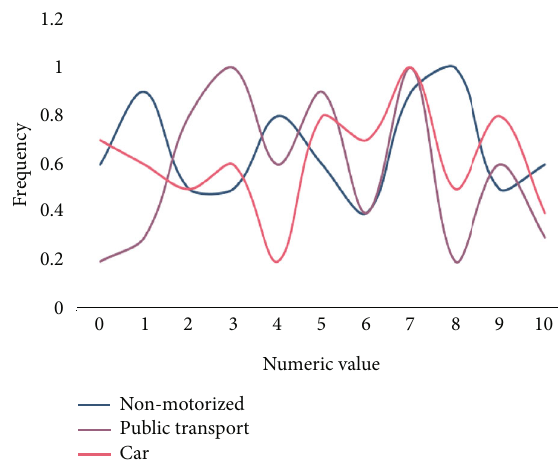
Figure 7: Farmers ’ migration travel